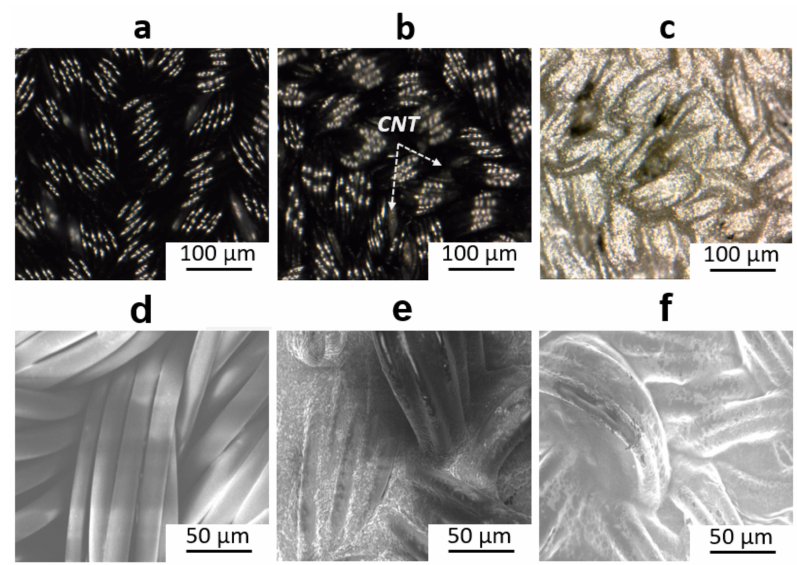
Figure 4. SEM images of surface under di ff erent processing steps, consisting of ( a ) surface of the fabric at 100 µ m before printing, ( b ) surface at 100 µ m after printing SWCNT, ( c ) surface at 100 µ m after printing silver paste, ( d ) surface at 50 µ m before printing, ( e ) surface at 50 µ m after printing SWCNT, and ( f ) surface at 50 µ m after printing silver